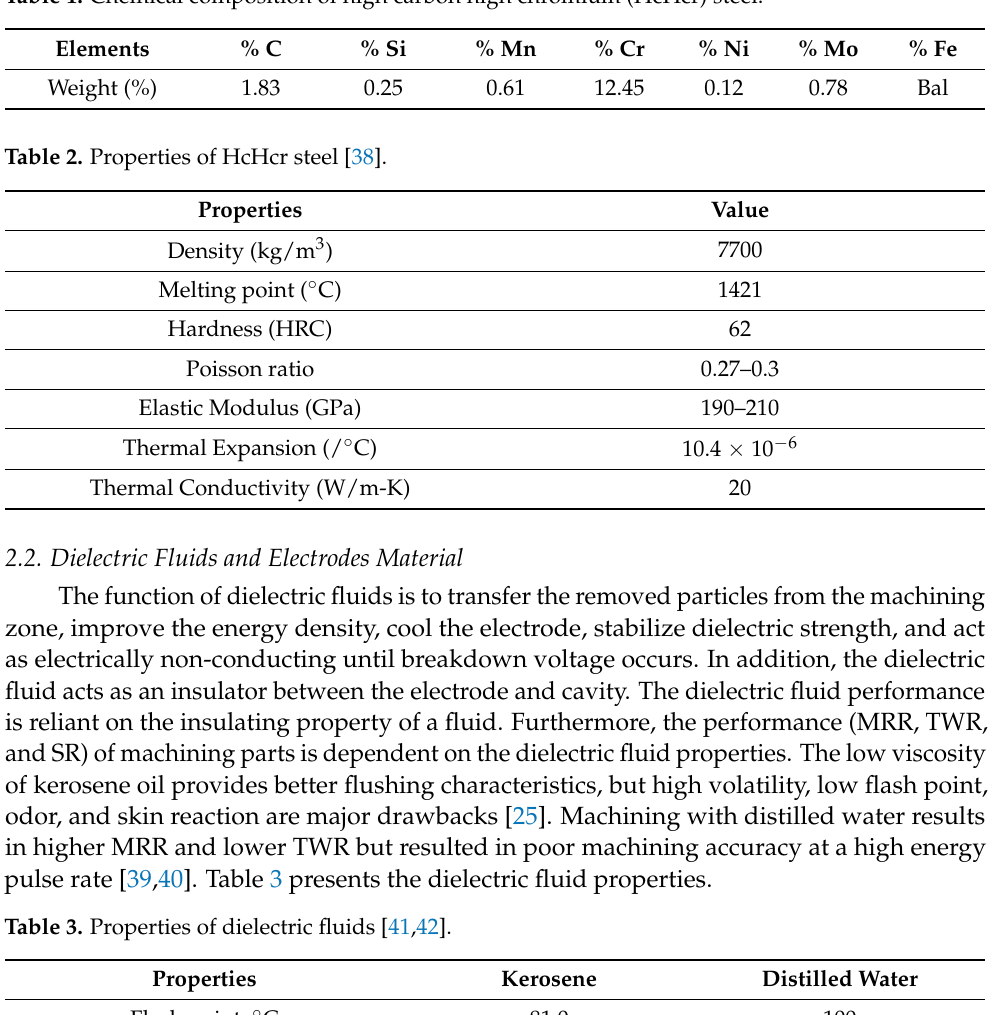
Table 1. Chemical composition of high carbon high chromium (HcHcr) steel.